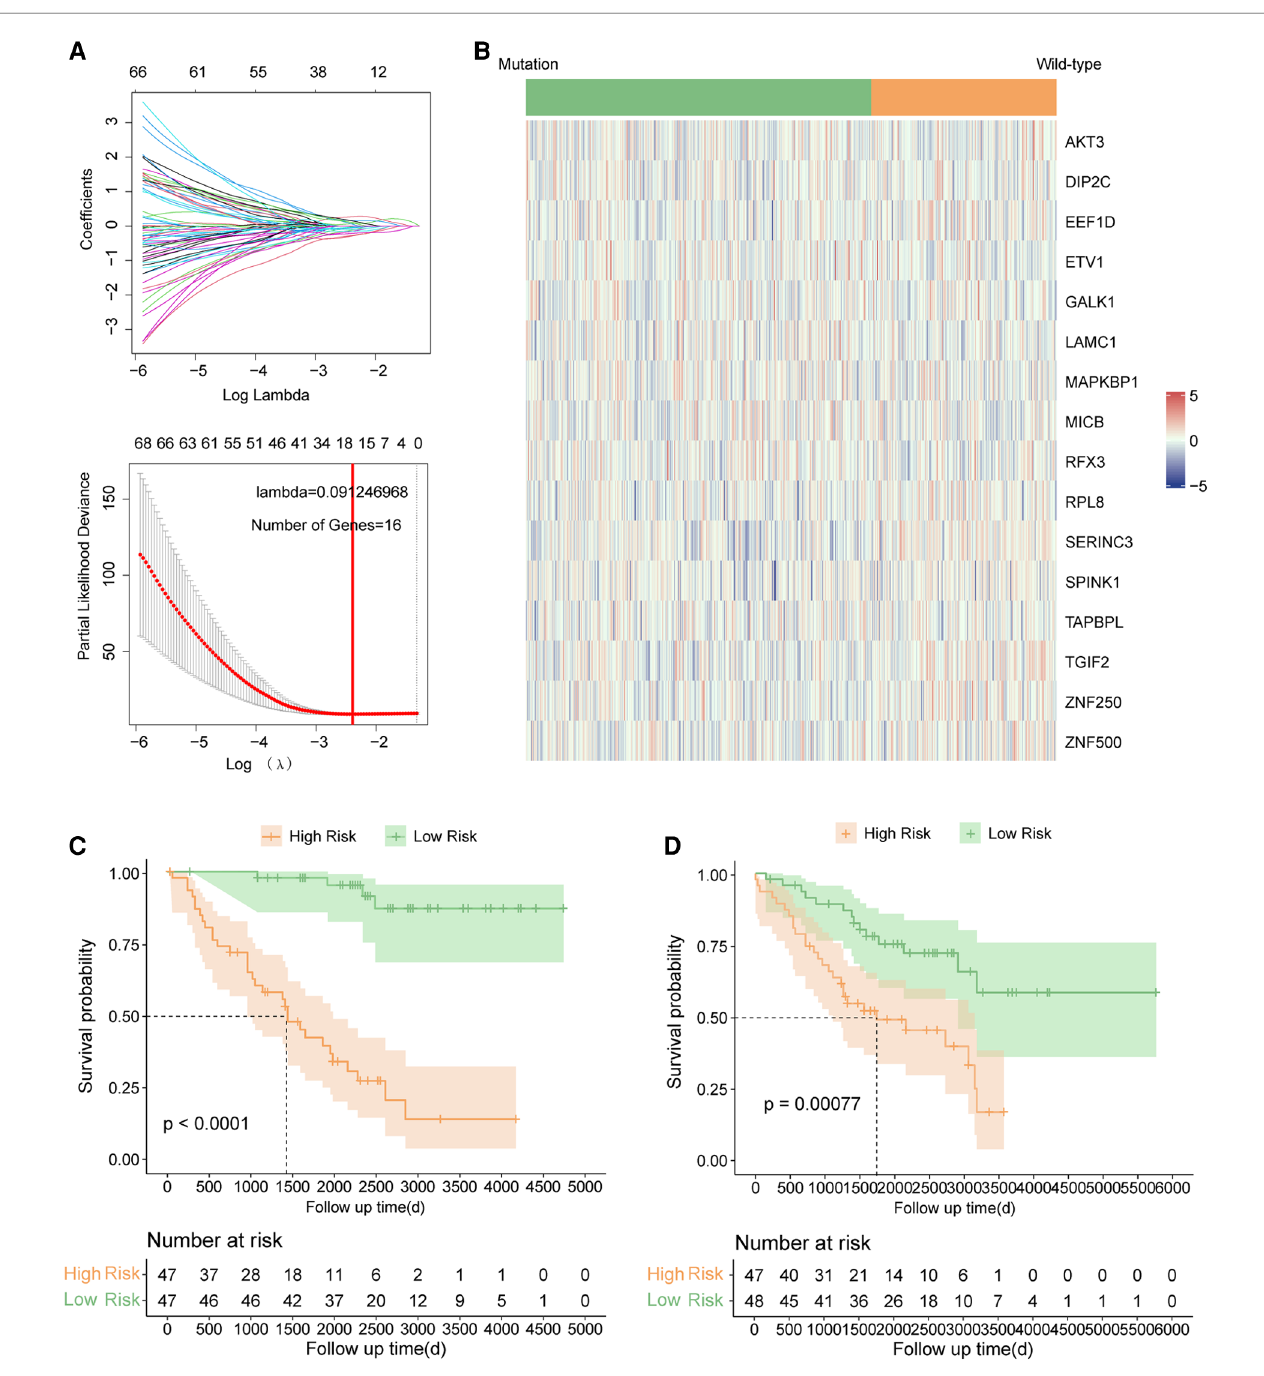
FIGURE 2 Signature construction in TP53 mutant COAD of GSE39582. ( A ) LASSO COX analysis. ( B ) Expression pattern of 16 signature genes. ( C ) Kaplan – Meier survival curve between high risk and low risk groups in the training set. ( D ) Kaplan – Meier survival curve between high risk and low risk groups in the testing